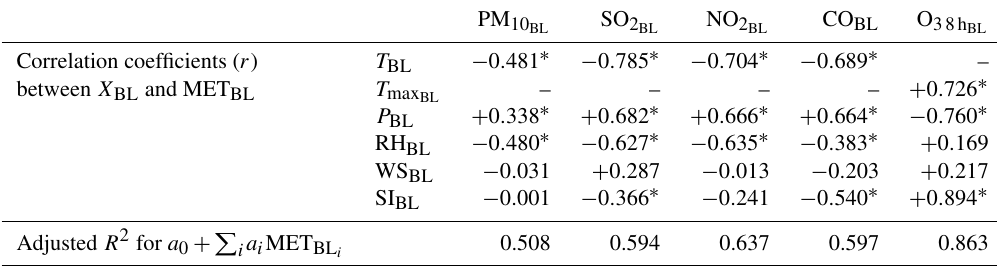
PM 10 SO 2 NO 2 CO BL O 38h BL BL BL BL BL WS